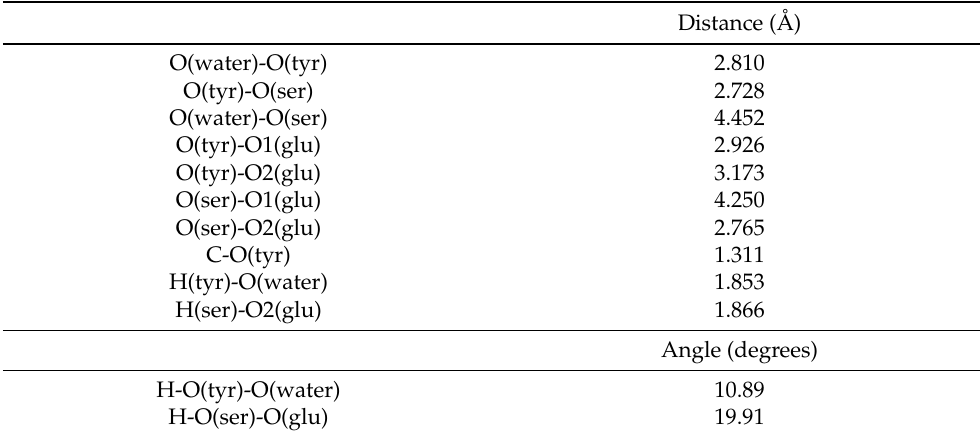
Table 4. Structural parameters (distance (Å) and angle (degrees)) of psamFP488 in the neutral form optimized in the Network2